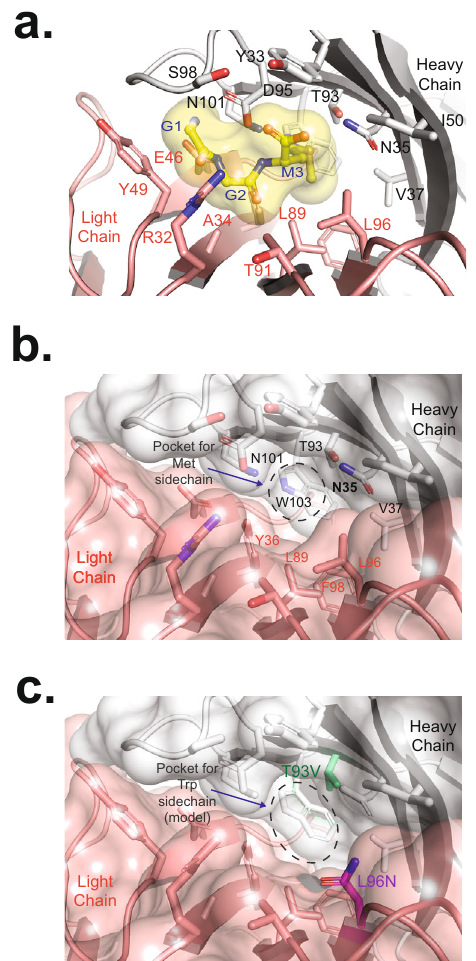
Fig. 2 Structural analysis of anti-GGX Fab bound to GGM peptide. a A detailed view of the interaction between the GGM peptide and the 1C7 Fab shows that the peptide resides within a pocket at the interface between the Fab heavy and light chain. GGM peptide is shown in yellow sticks with a transparent surface. The HC residues are shown as white sticks, and LC residues are shown as pink sticks. b A detailed view of the methionine sidechain recognition pocket located at the LC-HC interface, containing a mixture of hydrophobic and hydrophilic residues. The GGM peptide has been removed for clarity. The HC and LC residues are colored as before. The dashed circle highlights the pocket in which the GGM Met sidechain resides. c A structural model of the GGW Trp peptide pocket reveals two residue differences between 1C7 and 2B12 that may lead to the selective recognition of GGW by 2B12. The GGW peptide has been removed for clarity. The HC and LC residues are colored as before. The HC Thr93Val substitution is shown in green sticks, and the LC Leu96Asn substitution is shown in magenta sticks. The dashed circle highlights the pocket in which the GGW Trp sidechain would